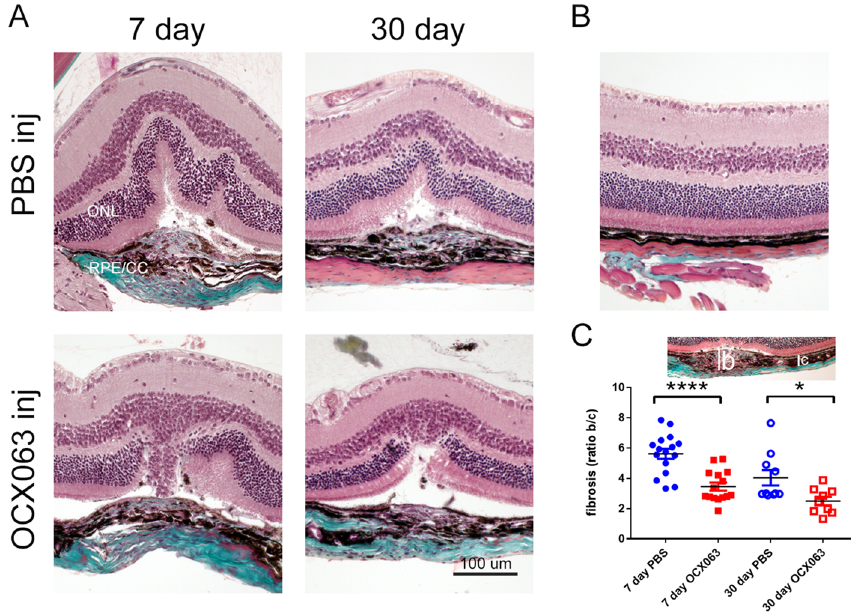
Figure 6. OCX063 reduced fibrovascular lesion size 7-days and 30-days following laser induced CNV. ( A ) Brightfield images of laser induced CNV retina with trichrome staining showing that fibrovascular lesions size was reduced with OCX063 treatment compared to PBS injected at both 7- and 30-days post CNV. Trichrome labels collagen (teal) and staining is visible in centre of fibrovascular lesion and in sclera were visible. Upper panel are PBS injected. Lower panel are OCX063 injected. ( B ) Brightfield image of control retina stained with trichrome showing trichrome staining limited to sclera. ( C ) Graph showing fibrosis (ratio B/C) was statistically smaller in OCX063 injected mice (red squares filled: 7 days, red square outline: 30 days) compared to PBS injected eyes (blue circles filled: 7 days, blue circles outline: 30 days). x-axis is treatment groups and y-axis is lesion ratio b/c. Insert shows lesion height measurements, b lesion and c choroid. Error bars ± SEM, *p < 0.05 and ****p < 0.0005 Tukey’s post-hoc following one-way ANOVA (n = 9 animals per group). B lesion height,